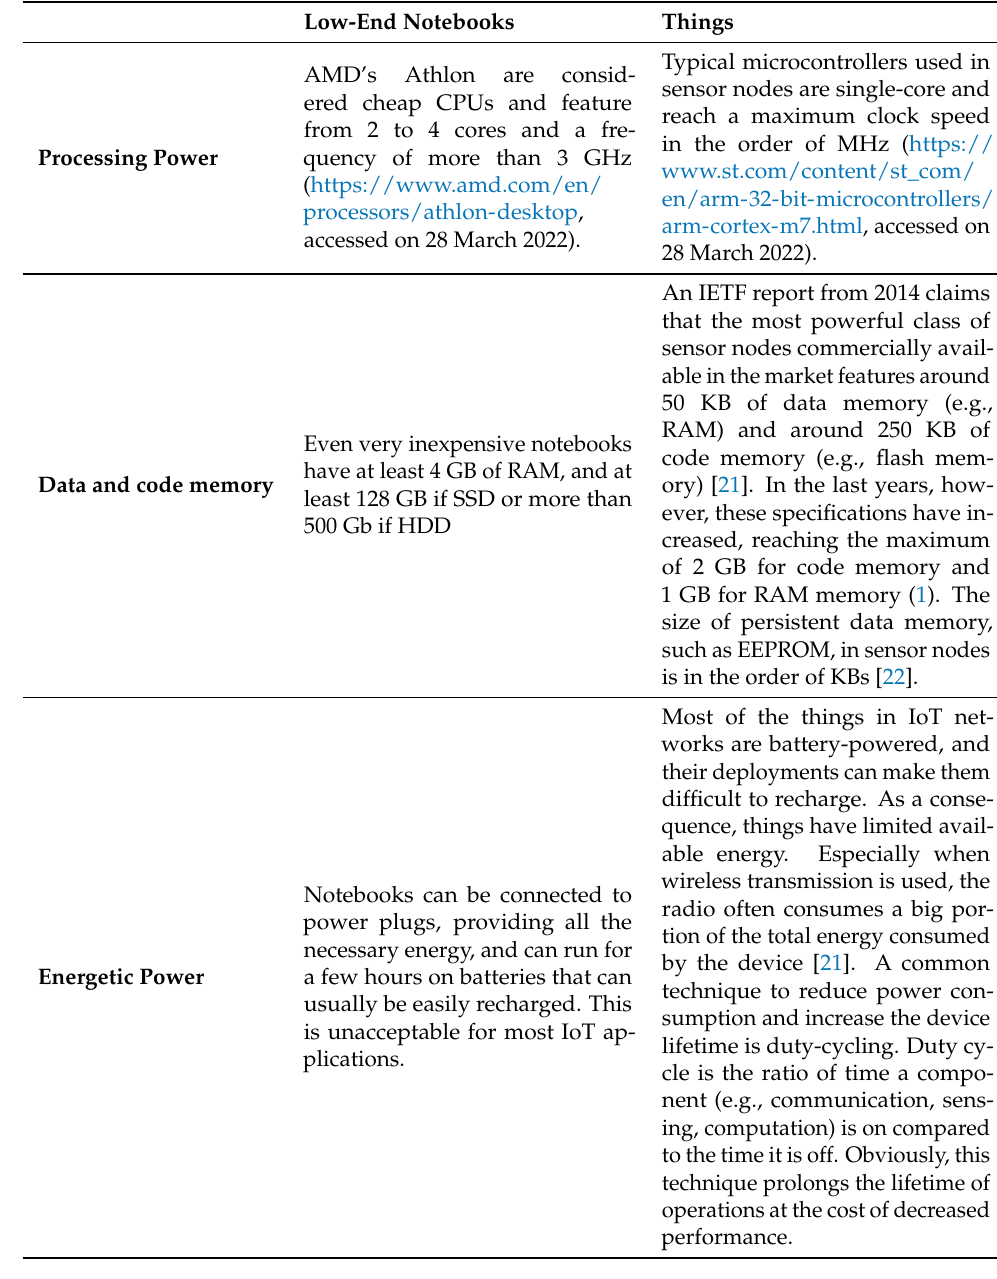
Table 1. A comparison of low-end notebook components with typical